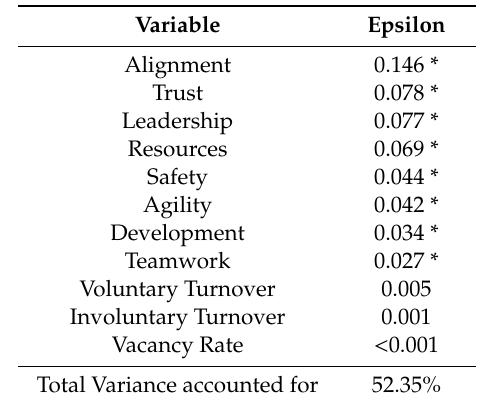
Table 7. Relative weights analysis predicting group level